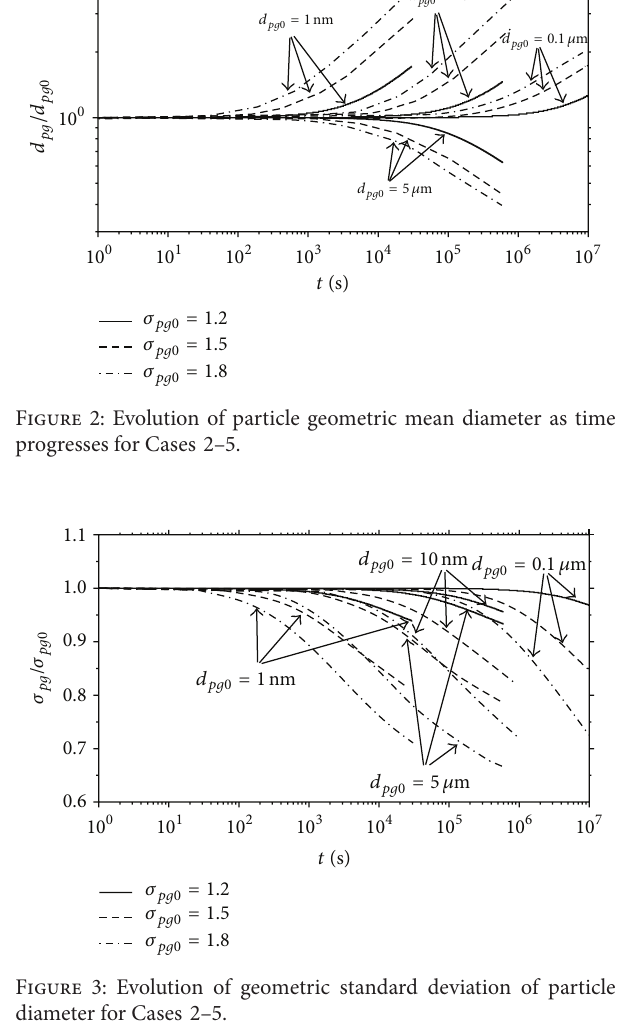
Figure 5: Effect of RSD on particle geometric mean diameter and geometric standard deviation ( 𝑑 𝑝𝑔0 =